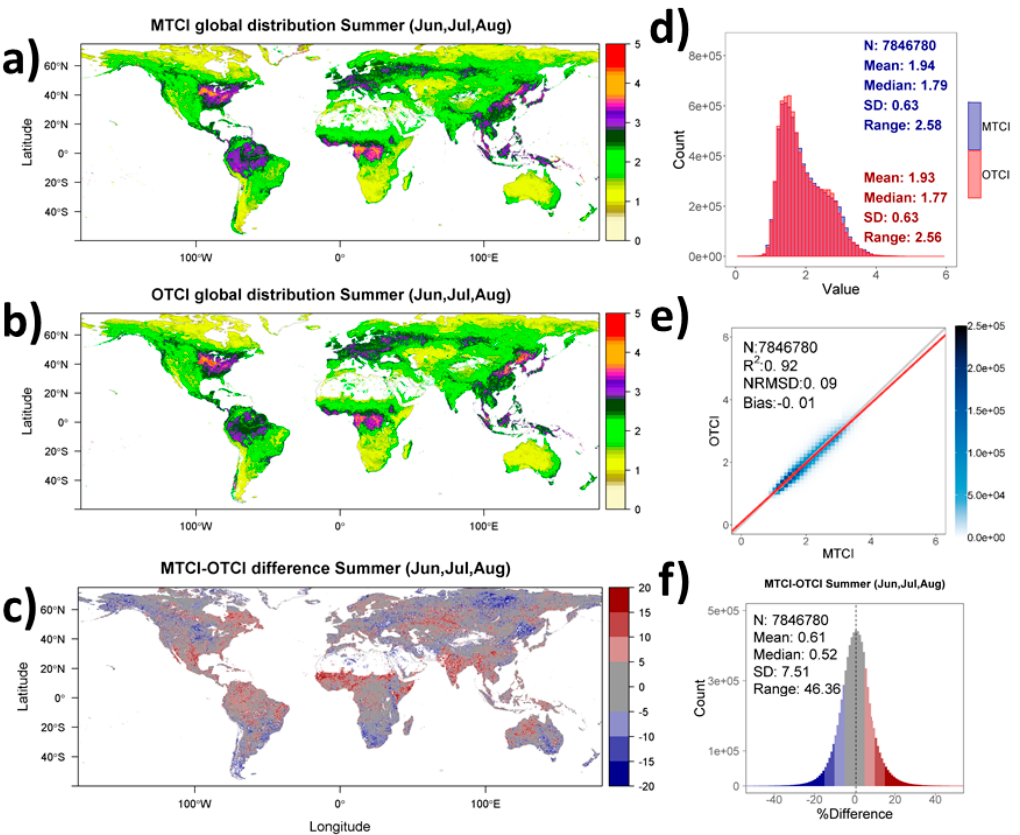
Figure 6. Global composites of Sentinel-3 OTCI (mean of 2016 to 2019) and Envisat MTCI (mean of 2002 to 2012) values for summer—i.e. Jun, Jul, Aug ( a , b )—and spatial distribution of differences ( c ). Index value frequency distribution ( d ), density scatterplot of agreement between the two products ( e ), and frequency distribution of differences ( f ). For ( c ) and ( f ), difference is expressed in percentage computed as the ratio of per pixel absolute difference to the mean. Blue indicates areas where the Sentinel-3 OTCI is greater than the Envisat MTCI, conversely, red indicates areas where the Envisat MTCI is greater than the Sentinel-3 OTCI. Grey pixels are areas where the difference between the Envisat MTCI and Sentinel-3 OTCI is within ±5%.